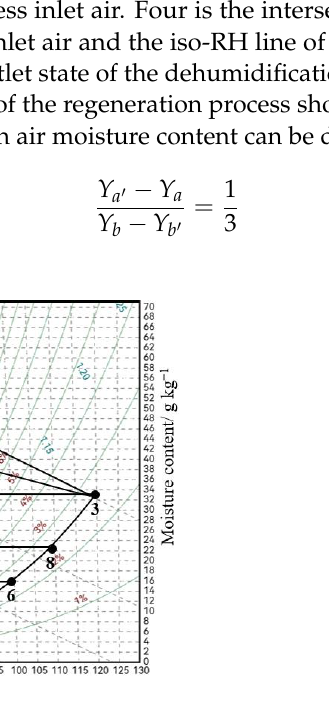
Figure 12. The state of the inlet and outlet air for the desiccant wheel dehumidification system.